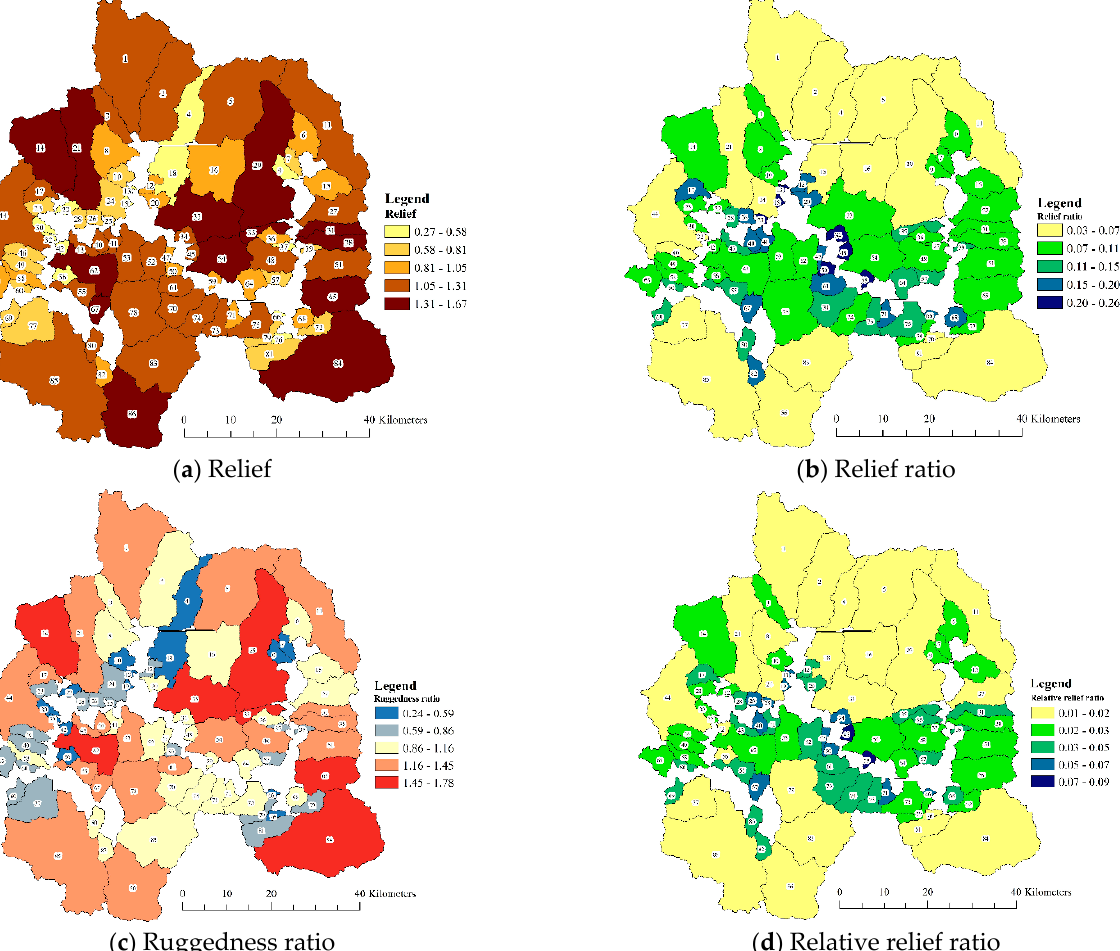
Figure 9. Spatial distribution of mean annual rainfall depth (1981 to 2020). 4.3. Unit Hydrograph Analysis The time of concentration, peak discharge, and time to peak are important parameters; in this work, these parameters were calculated using Snyder’s synthetic unit hydrograph method. Figure 10 illustrates the time of concentration of the subwatersheds considered in the study. Figure 11 illustrates the peak discharge of the subwatersheds. Figure 12 illustrates the time to peak of the subwatersheds. The times of concentration in the study range from 42.4 h (subwatershed no. 1) to 3.2 h (subwatershed no. 19). The times to peak range from 9.32 h (subwatershed no. 29) to 0.987 h (subwatershed no. 32). The peak discharges range from 141.96 mm (subwatershed no. 84) to 2.66 mm (subwatershed no. 13). Considering the relation between the time of concentration and morphometric parameters of the watershed, the time of concentration was high when the elongation ratio was low. The watersheds with low elongation ratio values indicate having quite elongated drainage basin shapes, so the surface runoff time interval is longer than that in basins with circular shapes. The relation between the time of concentration and elongation ratio can be generated using the power equation shown in Figure 13a. In addition, the time to peak also has the same relation with the elongation ratio; the relation between the time to peak and elongation ratio can be generated by obtaining a trendline using the power equation, as shown in Figure 13b. Moreover, in this study, it was found that the peak discharge also has a strong correlation with the elongation ratio, as shown in Figure 13c.